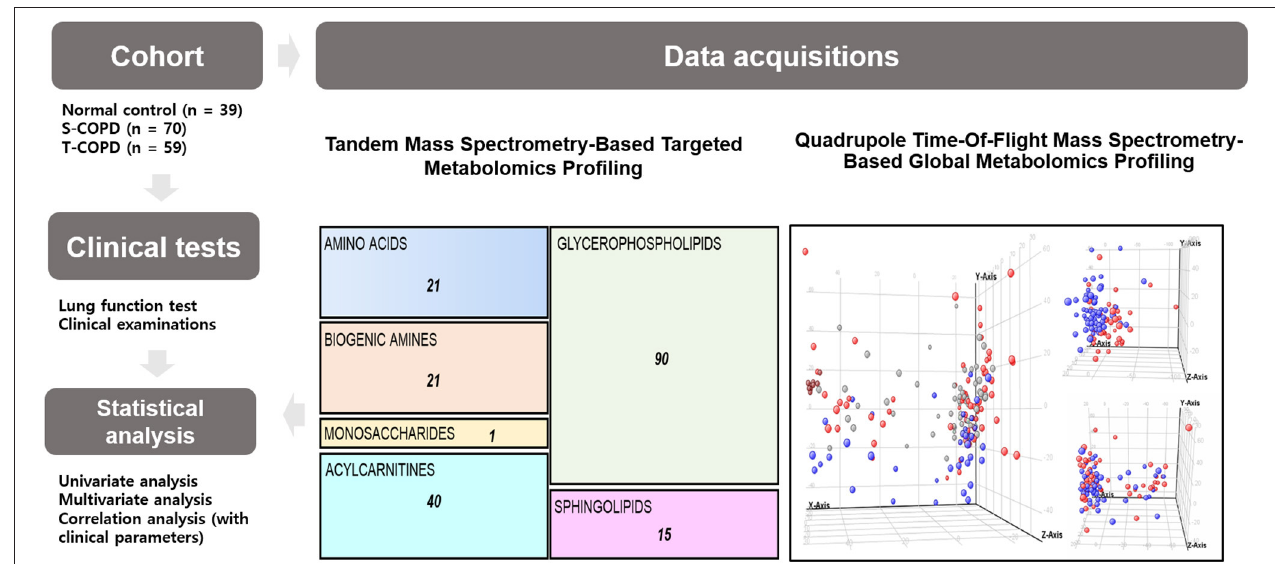
FIGURE 1 | Schematic of the study. This study included 39 healthy subjects, 70 patients with S-COPD, and 59 patients with T-COPD. All patients underwent clinical examinations, including lung function tests and metabolic profiling. For the targeted analysis, a tandem mass spectrometry-based technique was used. The absolute quantification of 188 metabolites, including 21 amino acids, 21 biogenic amines, one monosaccharide, 40 acylcarnitines, 90 glycerophospholipids, and 15 sphingolipids, was performed. For global metabolomic profiling, a QTOF-MS-based technique was chosen. Metabolic biomarkers were selected by performing multivariate and univariate analyses. The correlations of the metabolic biomarkers with clinical parameters were then calculated. NC, normal control; T-COPD, TB-associated COPD; S-COPD, smoking-associated COPD.